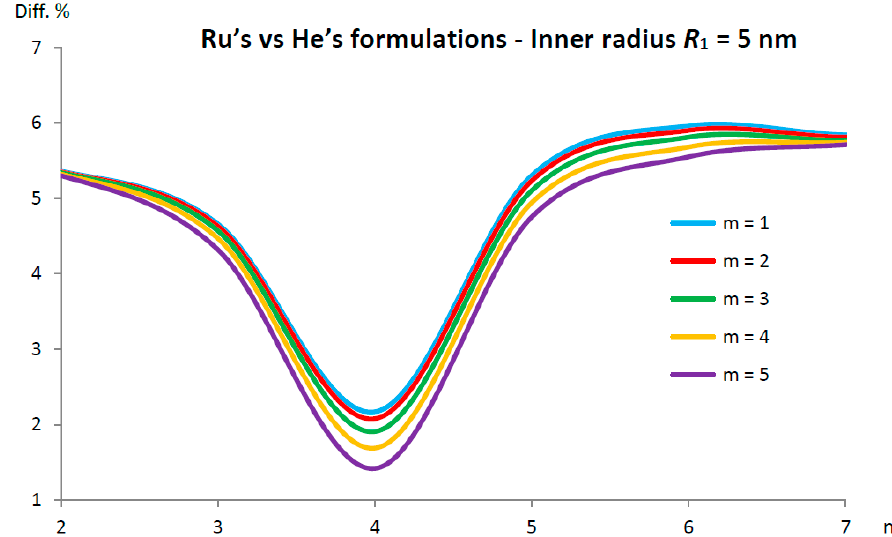
Figure 7. Percentage differences between the highest radial natural frequencies of the simply sup- ported DWCNT of Table 1 with inner radius R 1 = 5 nm and aspect ratio L / R 2 = 10 from Ru’s (38) and He’s (39) formulations. Donnell shell theory. Anisotropic elastic shell model. Number of longitudinal half-waves m . Number of circumferential waves n .